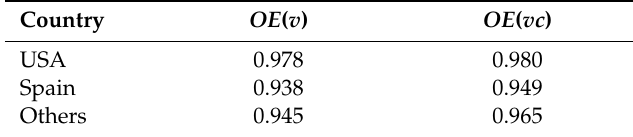
Table 8. Average input-based e ffi ciencies: three country groups.